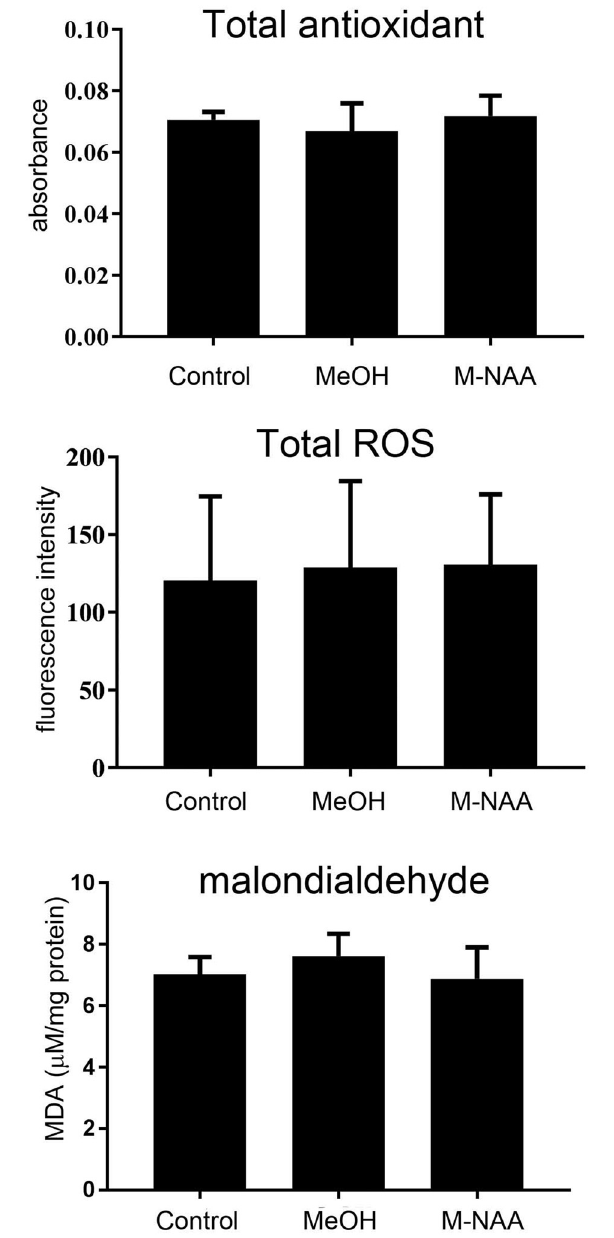
FIGURE 2 | Total antioxidants, reactive oxygen species (ROS) and MDA levels in brain; Values are expressed as means ± SD ( n = six mice per group). No significant differences were observed in any measure among the three